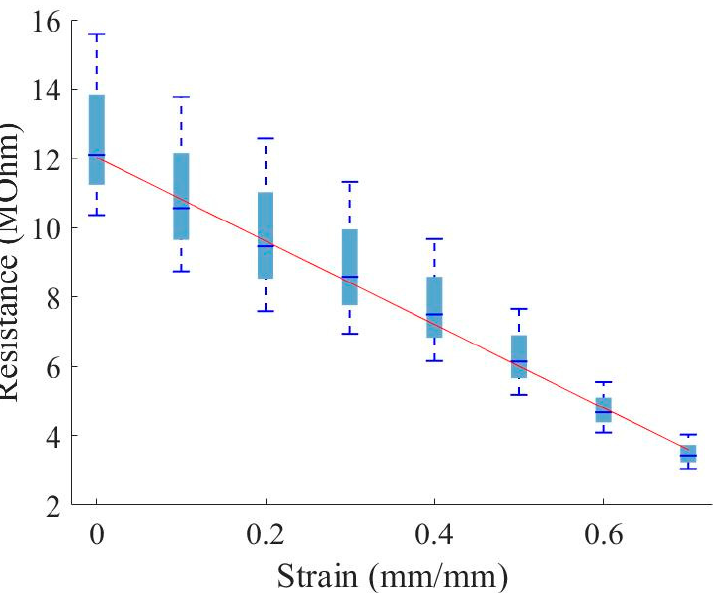
Figure 11. Resistance versus strain; resistance was measured across a 1 mm in-plane gap between copper strips.